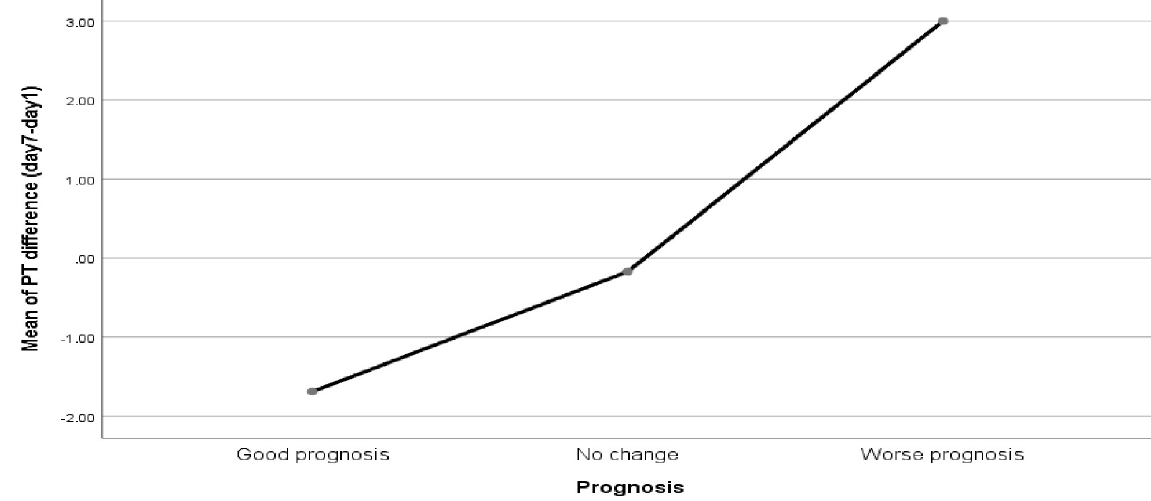
Fig 1. Mean prothrombin time change associated with disease prognosis (7 th day—baseline PT).